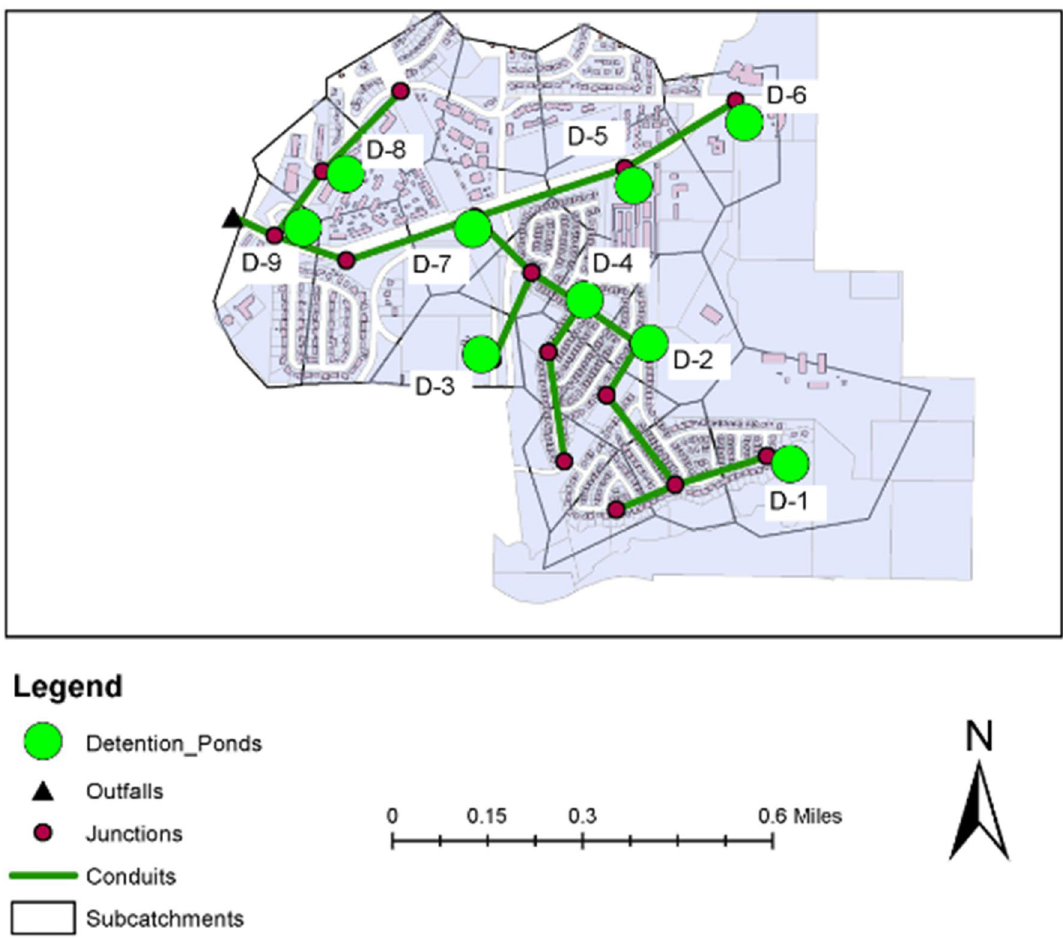
Figure 5. Drainage system in the Renton city watershed, with conduits, junction, outfalls, and